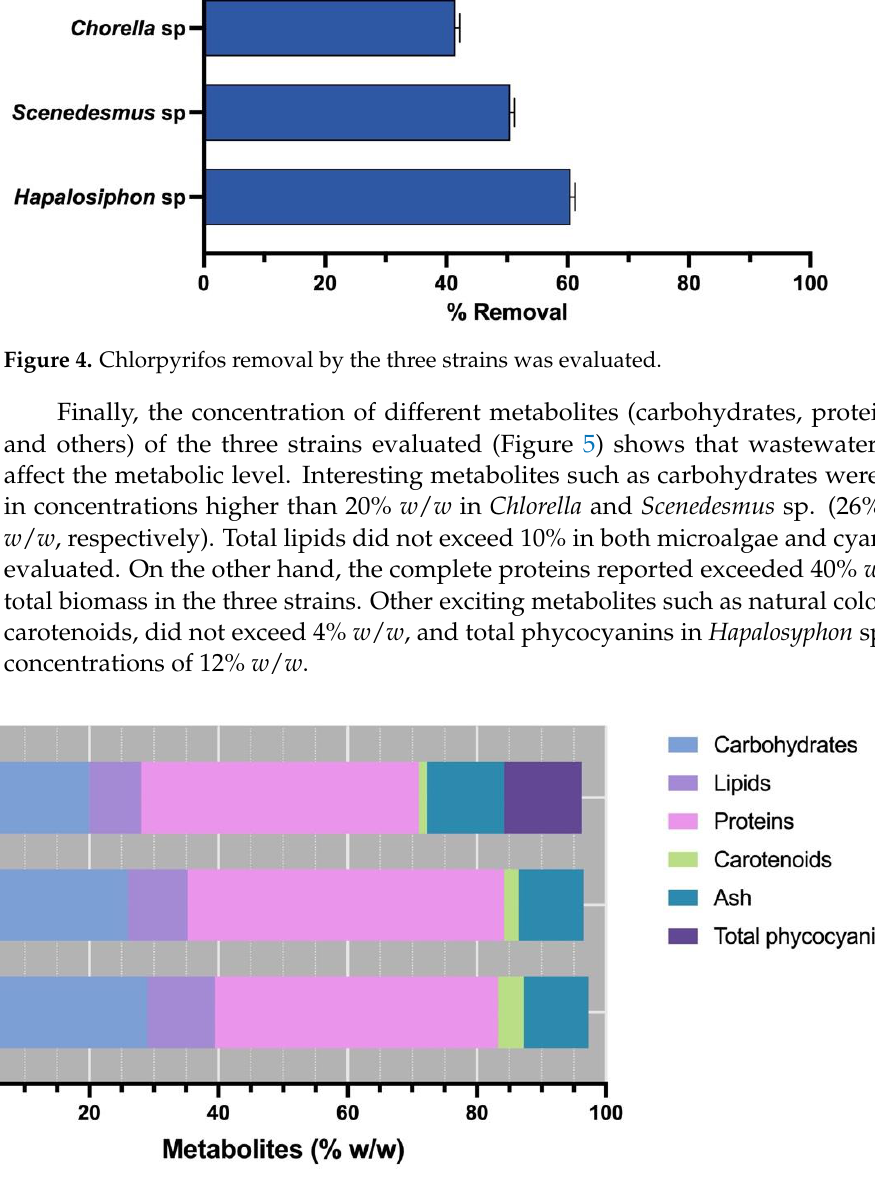
Figure 5. The concentration of different metabolites in the three strains cultured in agricultural run- off.